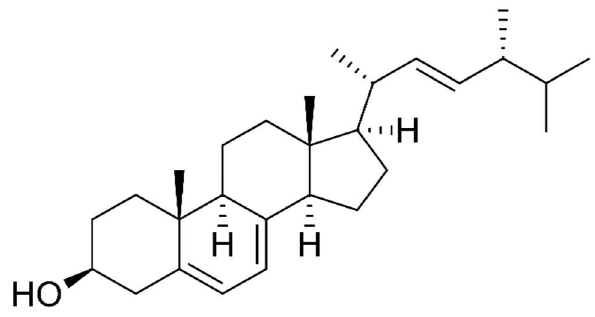
Figure 6. Ergosterol